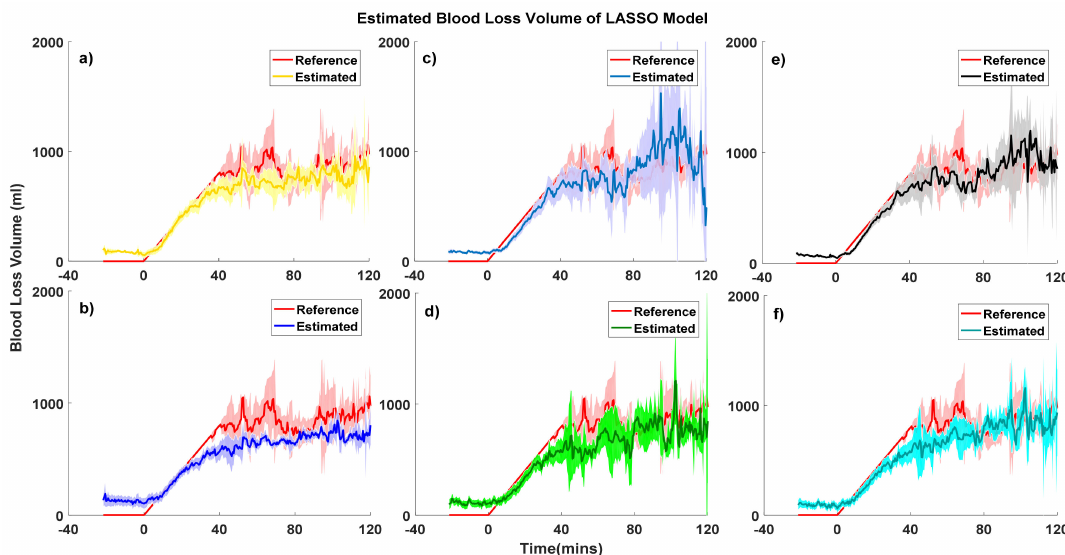
Figure 3. Estimated and reference blood loss curves of the least absolute square shrinkage operation (LASSO) model with 95% confidence intervals. ( a ) ABP personal model, ( b ) ABP grouped model, ( c ) PPG personal model, ( d ) PPG grouped model, ( e ) ABP&PPG personal model, and ( f ) ABP&PPG grouped